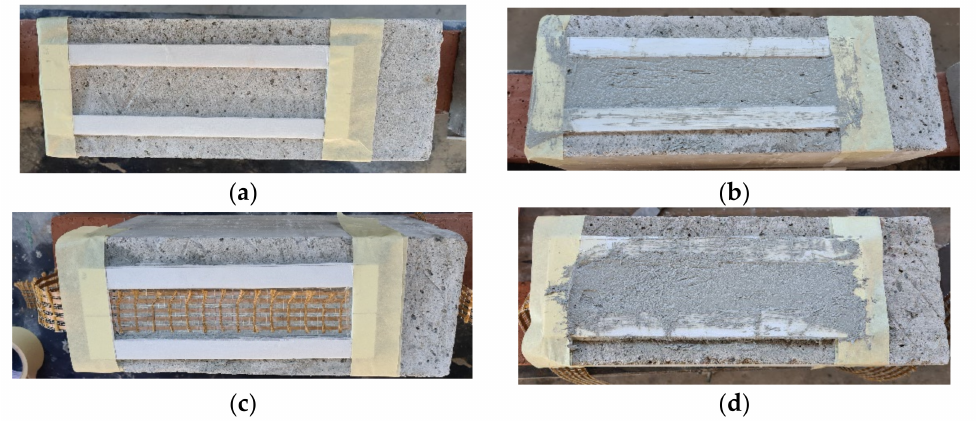
Figure 3. Specimen preparation strengthened with one layer: ( a ) Apply board panel, ( b ) apply internal layer, ( c ) PBO-fiber, and ( d ) apply external